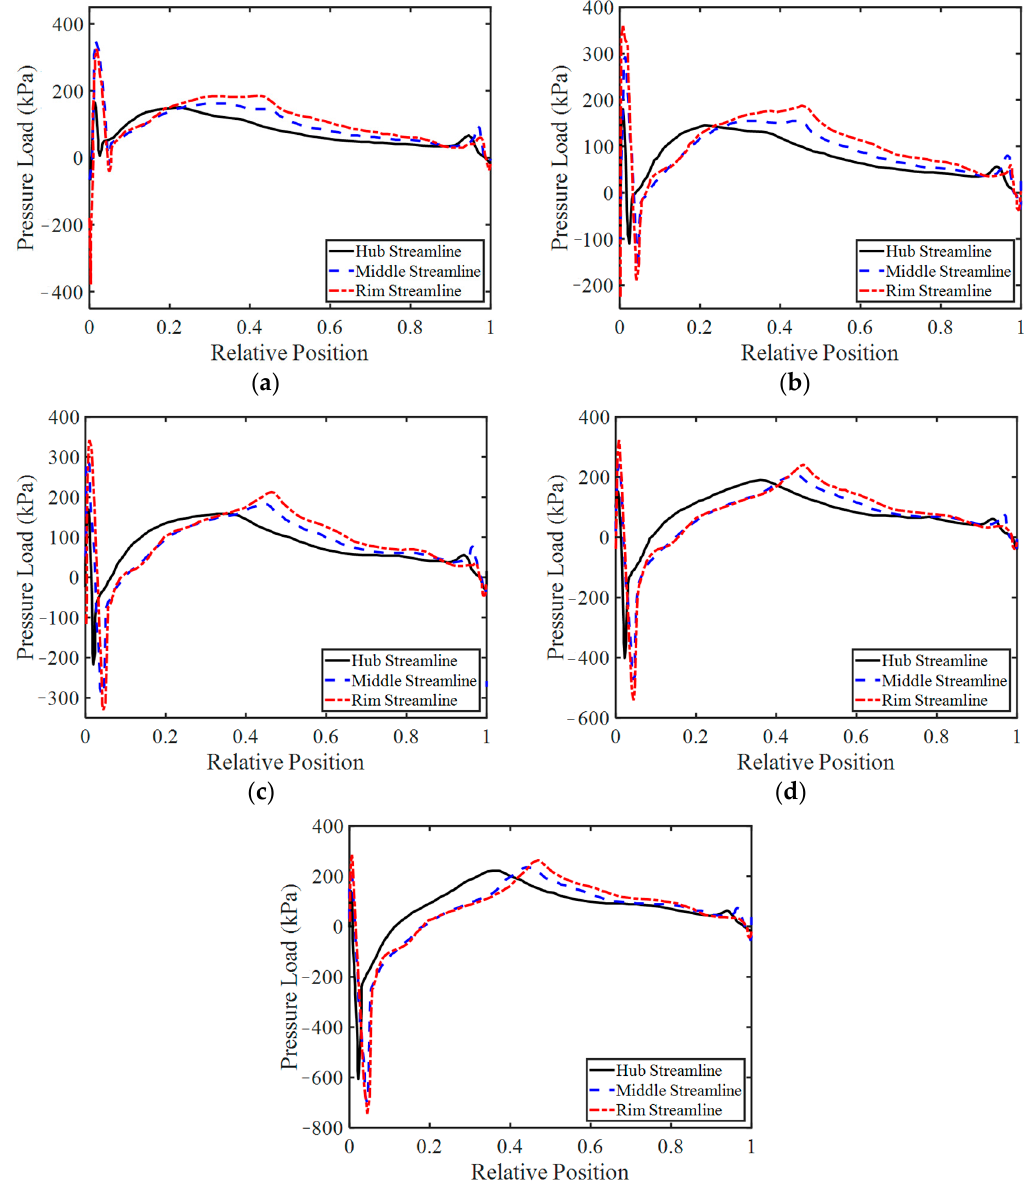
Figure 9. Pressure load distribution curves of helico-axial pump with different flow rates. ( a ) Q = 80 m3/h ( b ) Q = 90 m3/h ( c ) Q = 100 m3/h ( d ) Q = 100 m3/h ( e ) Q = 120